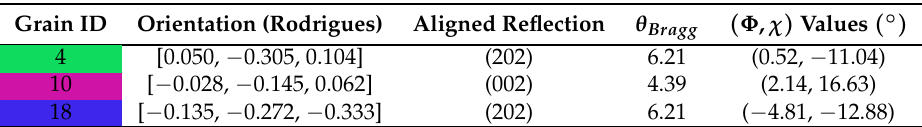
Figure 3. Details on the 3-grain cluster ( a ) 3D visualization of the grains ( b ); XZ slice through the 3 grains; ( c ) inverse pole figure of the gauge length with the 3 grain orientations of interest highlighted; ( d ) Θ integration range automatically determined at each loading step. Table 1. Details of the 3 grains selected for TT imaging; the orientation convention is consistent with [28]; and angle values are given in ◦